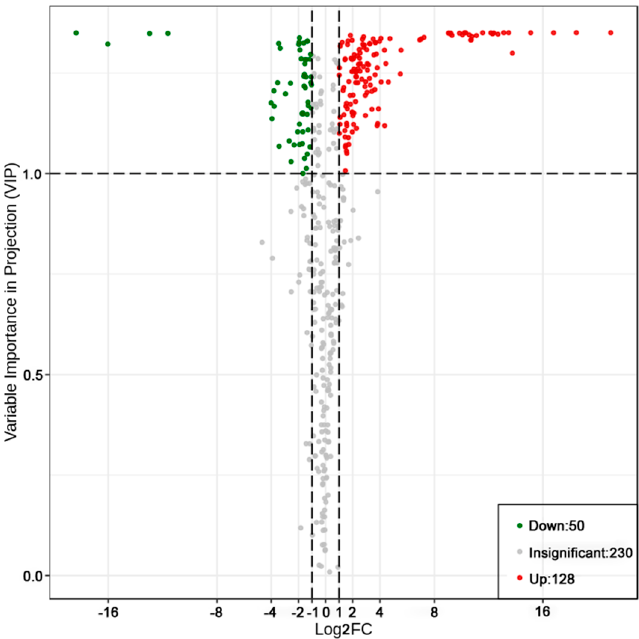
Figure 4. Differential metabolite analyses for SJL vs. SN with the criteria setting of variable importance in project (VIP) value ≥ 1 and FC ≥ 2 or ≤ 0.5, plotted by a volcano map. Red and green dots denote upregulated and downregulated differential metabolites, respectively; gray dots represent non- differential metabolites. Upregulation denotes that the content of a metabolite in SN exhibited a significant increase when compared with that in SJL. Conversely, downregulation indicates that the content of a metabolite in SN is significantly decreased when compared with the corresponding one in SJL. The recognized differential metabolites between SJL and SN were further subjected to heatmap analysis to picture their relative contents (Figure 5). As shown in Figure 5, SJL sections composed of red and green color-coding are clearly distinguishable from those of SN, demonstrating significant differences in the relative contents of differential metabolites between SJL and SN. Figure 5. A heatmap for the relative variation of metabolites between SJL and SN. The color-coding from red to green indicates abundances from high to low, respectively.